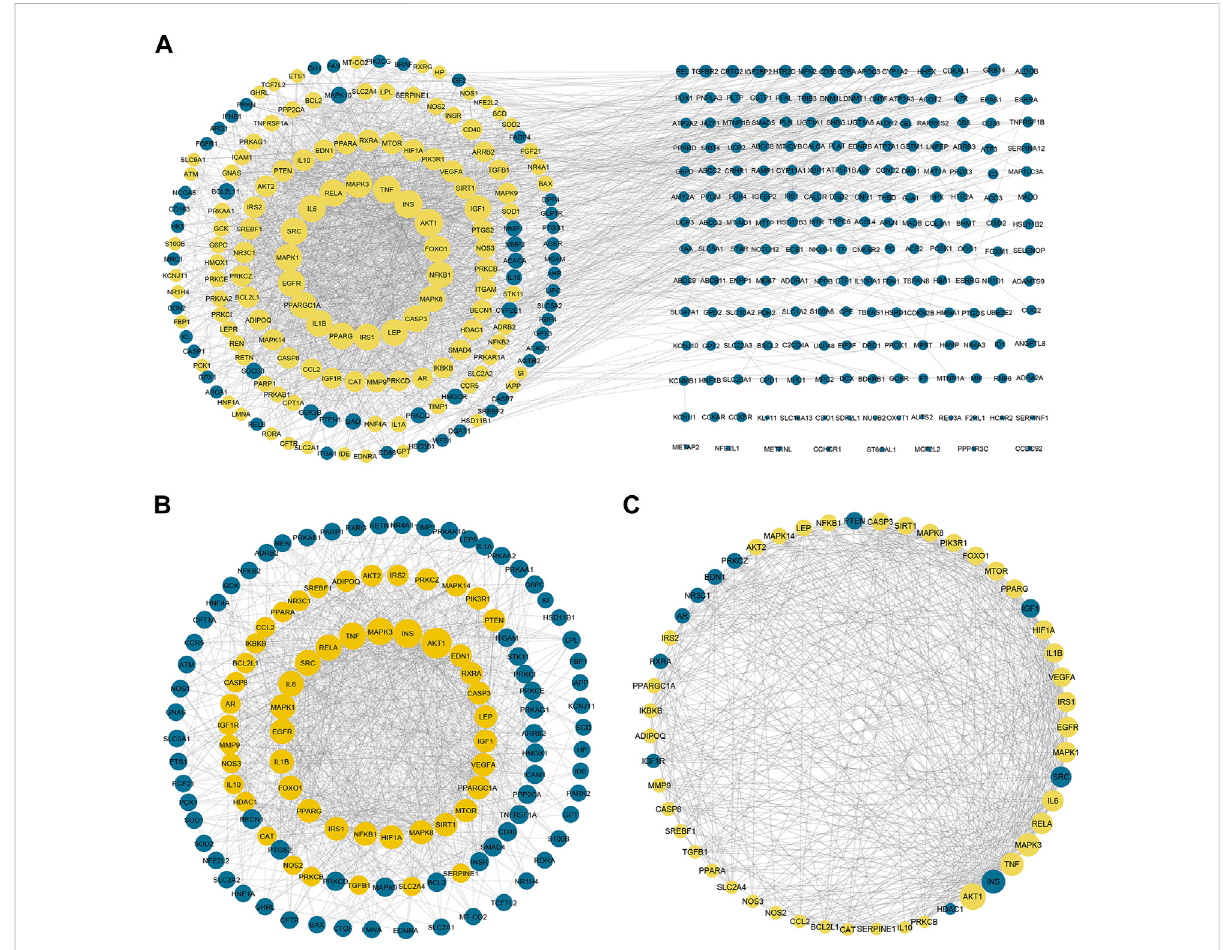
FIGURE 5 Protein-protein interaction networks. (A) PPI network of 363 targets of MA. Yellow nodes represent the hubs that will form the following network (B) representsPPIof123hubswhosecentralityvaluesaregreaterthanthemedian.Theyellownodesrepresentthemajorhubsthatwillform thefollowingnetwork (C) representsPPI ofthemajor hubsorcore keytargetswhose centrality values aregreaterthan themedian ofthehubnodes. Theyellownodesrepresentthecorekeytargetsthatareaffectedbymorethansixcompoundsandwillformthenetworkofthefollowing fi gure. The blue nodes in (C) represent targets that affected by less than seven compounds. Adjusting the size of the images and resolution, adding the panels ’ letters, and combining the images was carried out using